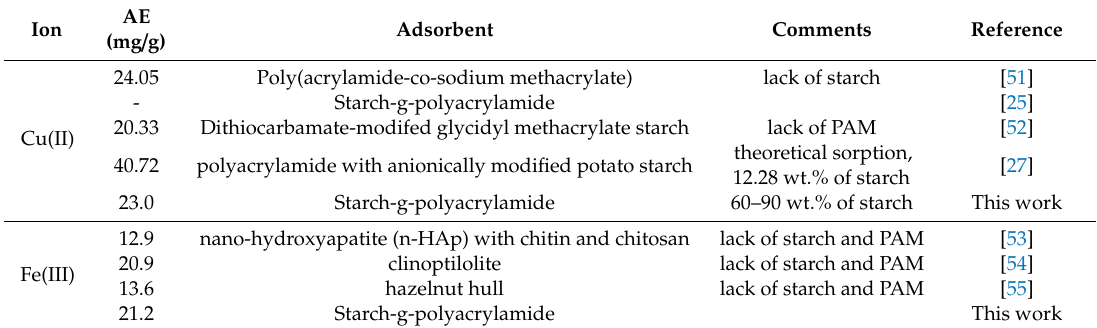
Table 3. Adsorption e ffi ciencies (AE) of Cu(II) and Fe(III) for various adsorbents with maximum AE.